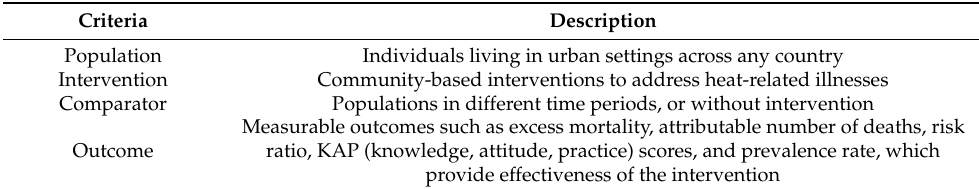
Table 1. PICO elements used to frame the search